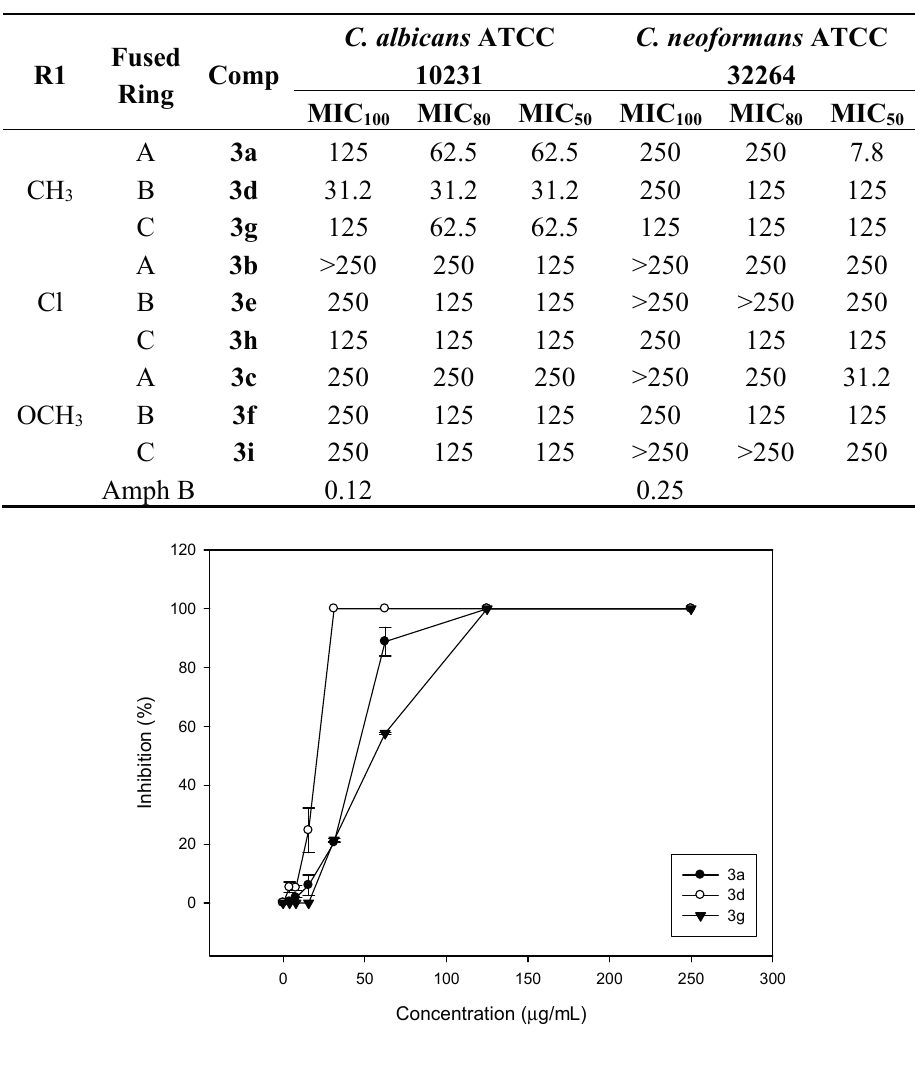
Figure 1. Comparative curves of the growth inhibition of C. albicans ATCC 10231 produced by compounds 3a , 3d and 3g at different concentrations. Inhibition percentages are the means ± SD obtained from experiments in